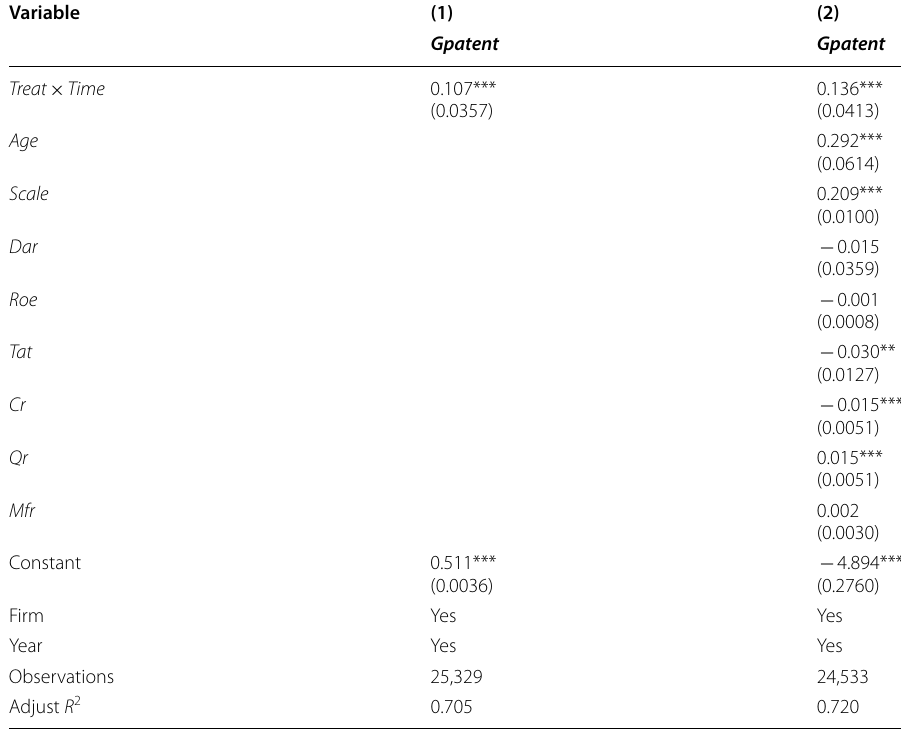
Table 3 Benchmark regression